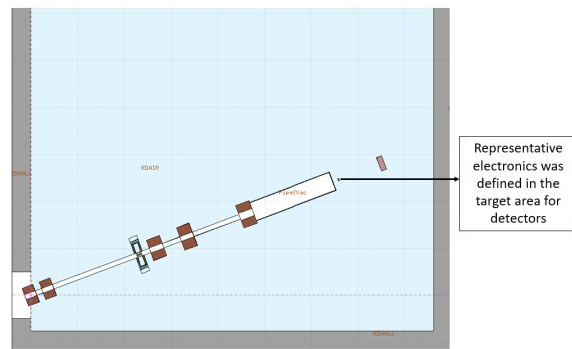
Fig. 6. Modeling of METU-DBL as seen in the graphical interface of FLUKA called Flair. Beam elements such as magnets are seen as brown rectangles around the beam pipe. An electronic component in the target area was placed to represent detectors and their readout electronics to determine the necessary shielding